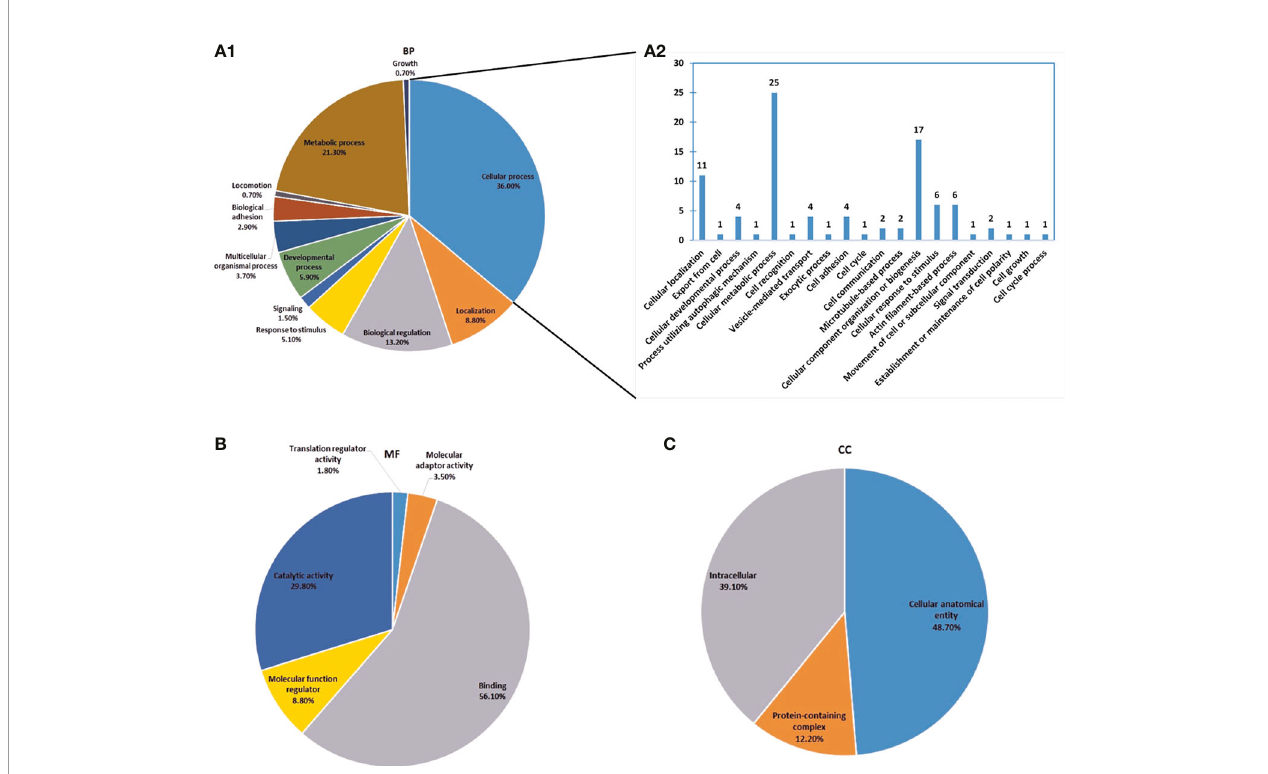
FIGURE 2 | Gene Ontology (GO) analysis of phosphorylated proteins of Haemaphysalis longicornis tick saliva. The percentages of proteins assigned to the different terms are shown. (A1, A2) Biological process, with the expansion of the cellular process sector in A2. (B) Molecular function; (C) Cellular